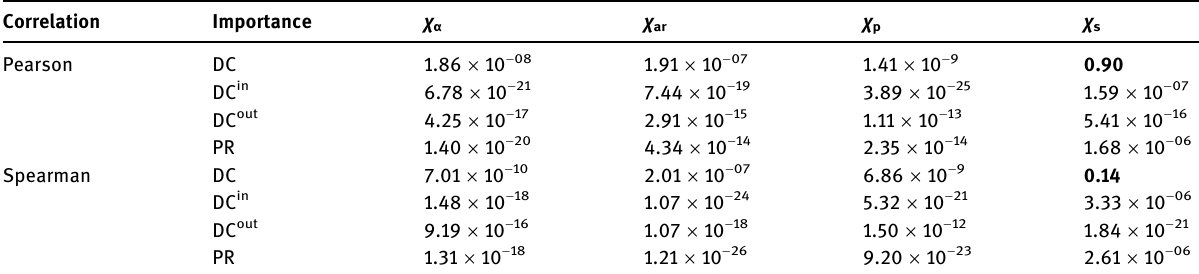
Table 4: Pearson and Spearman signi fi cance test between element electronegativity and node importance under 0.001 signi fi cance level ( where the values in bold are the ones bigger than 0.001 )